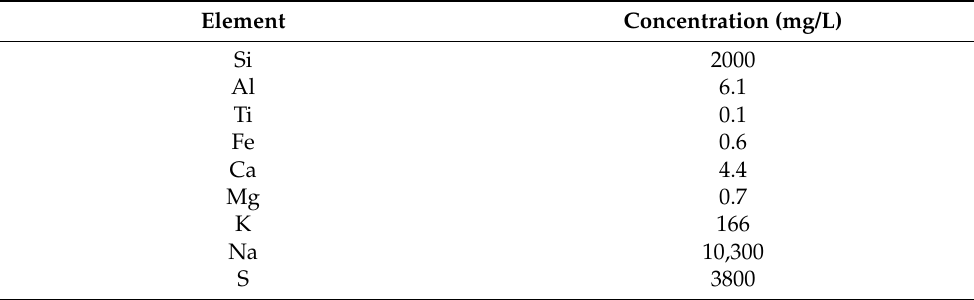
Table 2. Chemical composition of the leachate pore solution (LPS). The measurements of the most concentrated elements were carried out using a 1:100 diluted solution. Element Concentration (mg/L) Si 2000 Al 6.1 Ti 0.1 Fe 0.6 Ca 4.4 Mg 0.7 K 166 Na 10,300 S